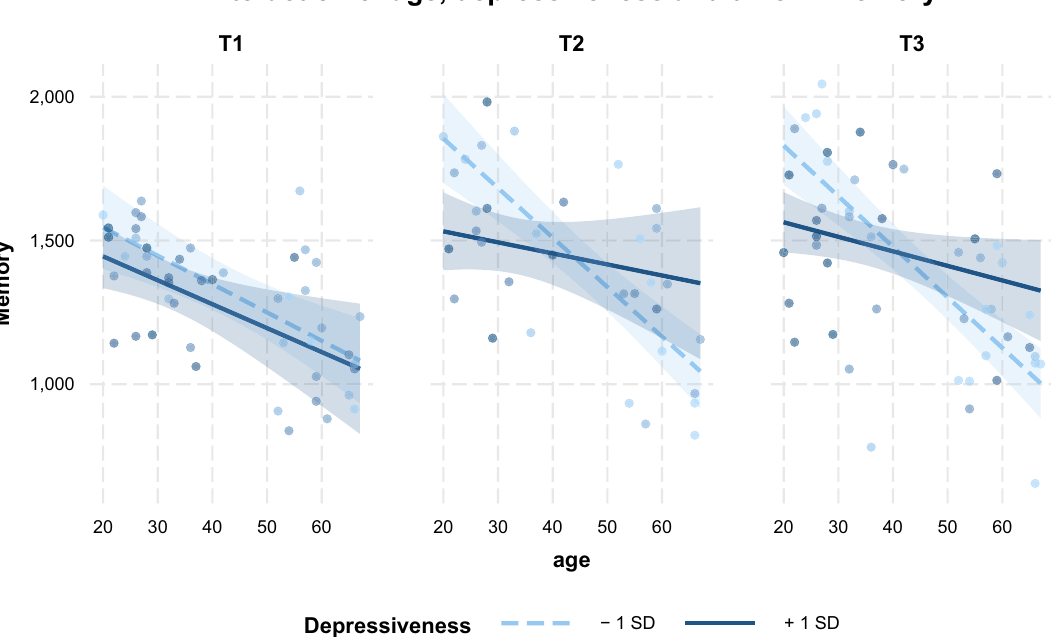
Figure 6. Interaction between age, depressiveness and time on memory task performance. Shaded areas represent 90%-confidence